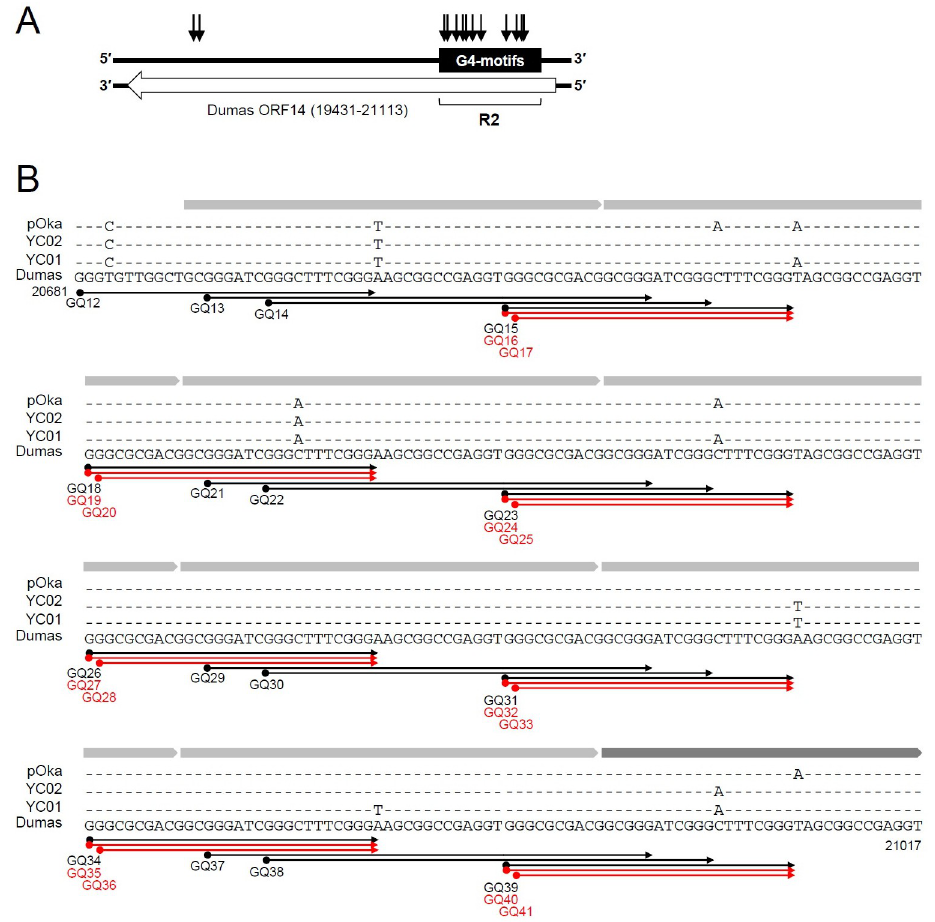
Fig 2. Putative G4 motifs in R2 within ORF14. (A) The position of the ORF14 coding sequence is indicated as an open arrow on the bottom strand of the VZV Dumas genome and the region containing putative G4 motifs in R2 is indicated as a black box on the top strand. The variations found in ORF14 of pOka, YC01, or YC02 compared with Dumas are indicated as black vertical arrows. (B) The G4 motifs (GQ12 to GQ41) found in R2 are indicated below the genome sequence of Dumas (from 20681 to 21017). The variations found in pOka, YC01, and YC02 are indicated above the Dumas sequences. All G4 motifs of R2 are predicted on the anti-sense strand of ORF14. Black arrows, GQs for long-looped G4; red arrows, GQs for bulged G4. Seven 42-bp elements and one 32-bp element in R2 are indicated as light and dark grey bars, respectively, above the